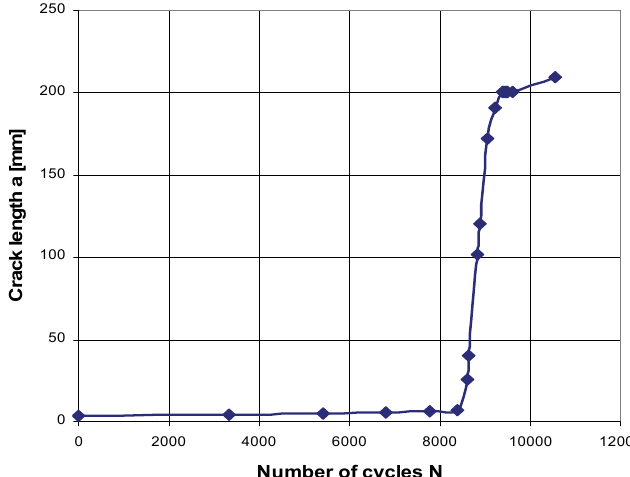
Figure 13: Relationship between crack length a and number of cycles N using 3D